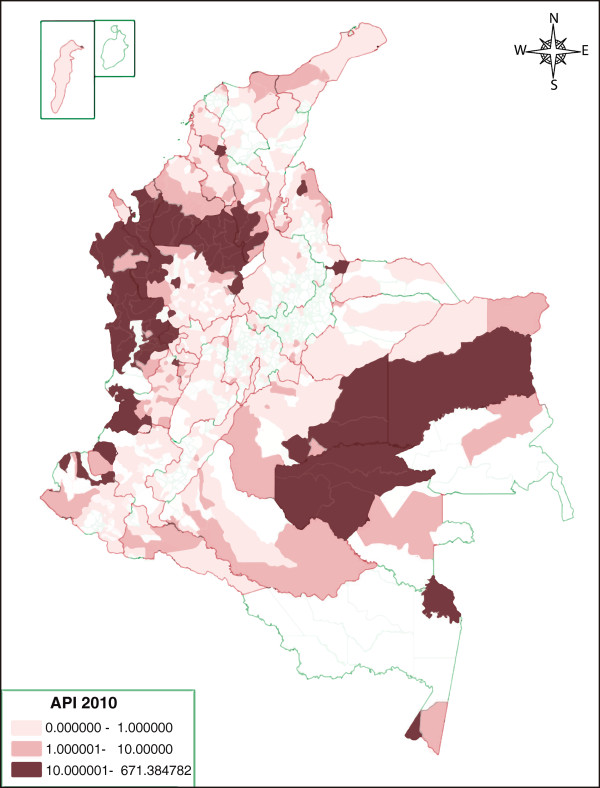
Annual parasite index by territorial entity.